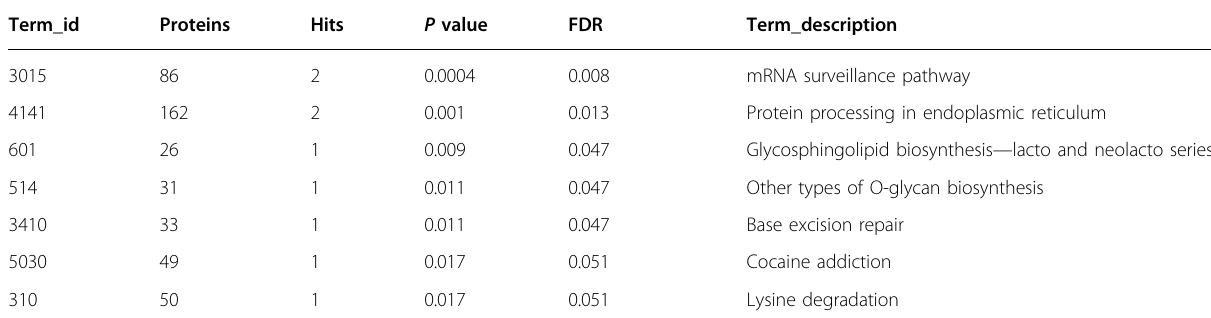
Table 2 Pathway enrichment